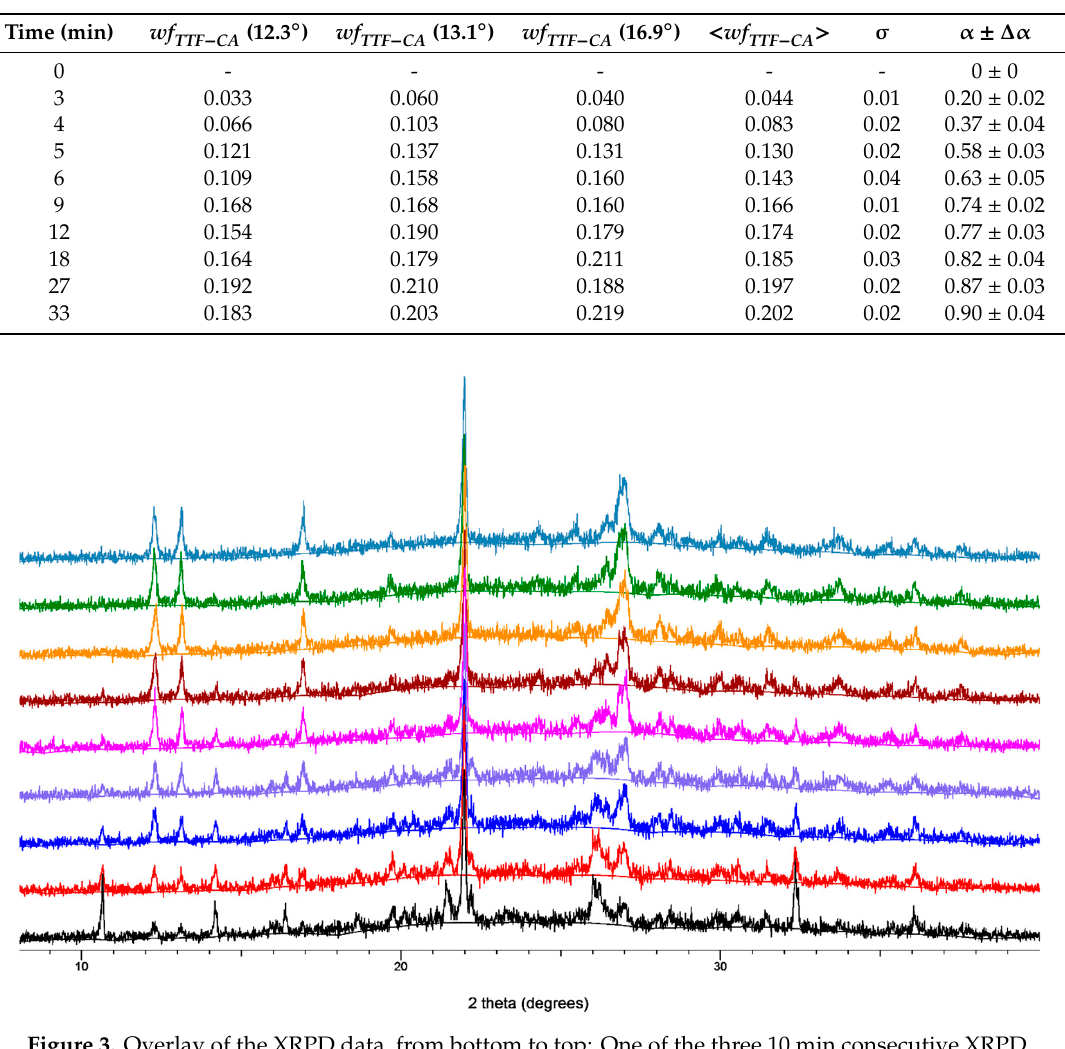
Figure 3. Overlay of the XRPD data, from bottom to top: One of the three 10 min consecutive XRPD scans of the neat mechanochemical products collected immediately after grinding TTF and CA for: 3 min (black), 4 min (red), 5 min (blue), 6 min (violet), 9 min (magenta), 12 min (brown), 18 min (orange), 27 min (green) and 33 min (light blue). Note the peak of the standard at 22.0 ◦ common to all patterns. After the calculation of intensity ratios from each scan, the calibration curves in Figure S1 were used for the calculation of the weight fraction of TTF-CA (green polymorph) in each reaction mixture, m t and the conversion fraction α using Equation